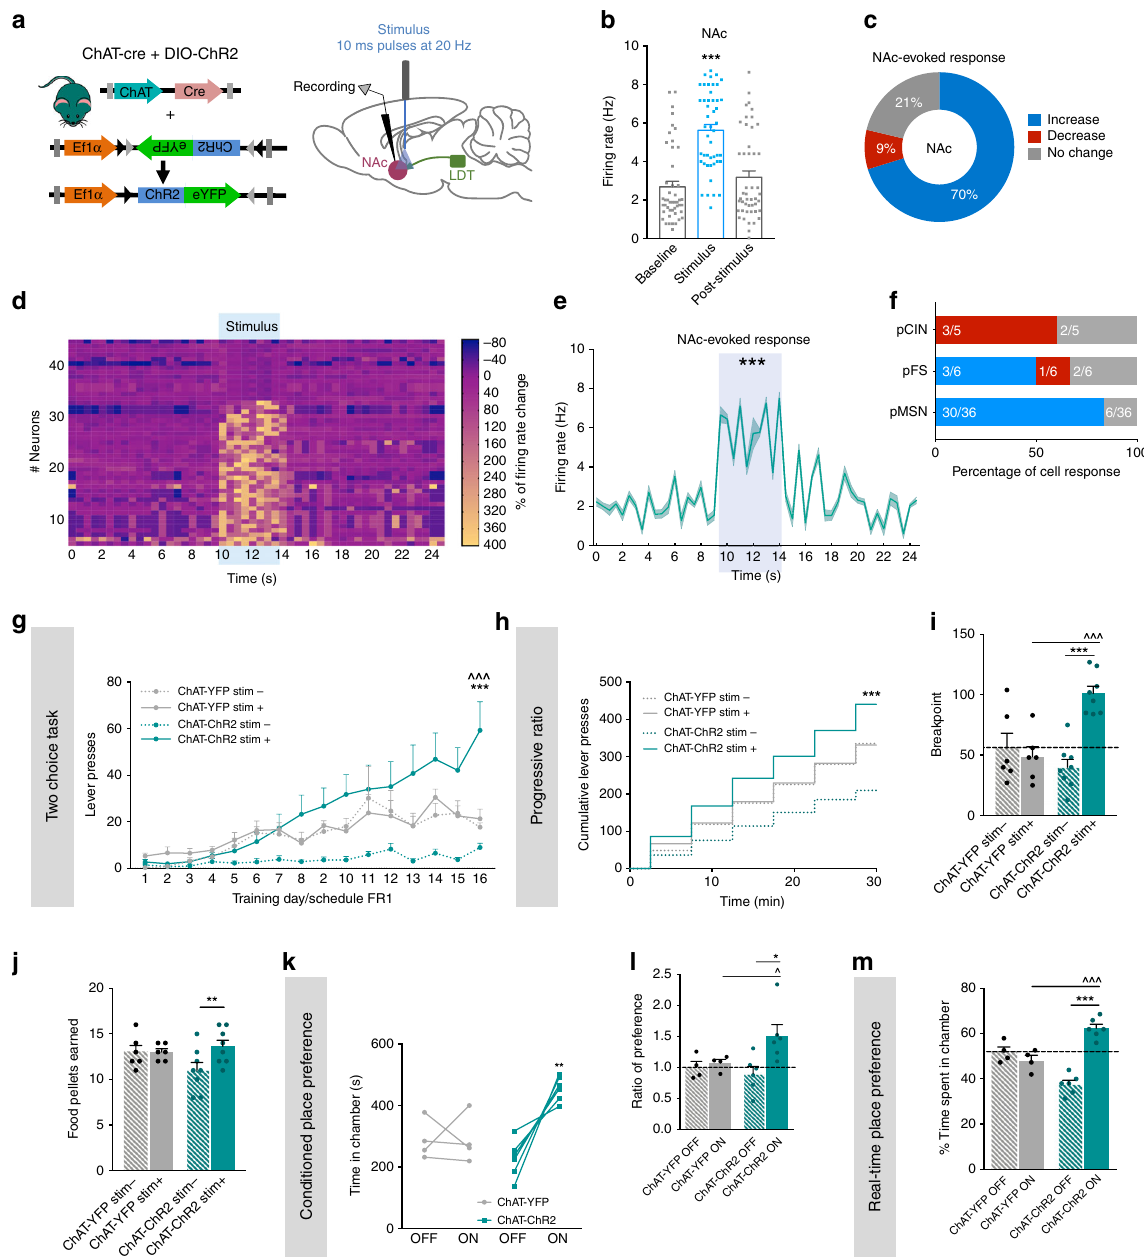
Fig. 4 Activation of LDT-NAc cholinergic terminals increases motivation and induces preference. a Strategy used for optogenetic manipulation of LDT cholinergic terminals in the NAc. DIO-ChR2 was injected in the LDT of ChAT-cre mice, and optical stimulation was performed in the terminals in the NAc. b LDT cholinergic terminals stimulation increase NAc net fi ring rate ( n = 5 animals; 47 cells; RM 1way ANOVA). c The majority of NAc cells show an increase in the fi ring rate during stimulation, 21% present no change and 9% decrease activity. d Heatmap representation of percentages of cell responses in the NAc when LDT cholinergic terminals are stimulated. e Average distribution fi ring rate of NAc neurons showing an increase in activity during stimulation period (KS test). f Percentage of responses of each NAc cell type to cholinergic LDT terminal activation. g Time-course representation of the responses in the two-choice task of ChAT-ChR2 ( n = 8) and ChAT-eYFP ( n = 6) mice. Activation of LDT-NAc cholinergic terminals enhances responses for stim + lever in ChAT-ChR2 animals, but not in control ChAT-YFP group. h Cumulative presses performed during the progressive ratio task show that ChAT-ChR2 animals press more on stim + lever. i Increased breakpoint for stim + lever in ChAT-ChR2 animals, indicative of enhanced motivation. j Number of pellets consumed during progressive ratio sessions. k – l In the CPP, ChAT-ChR2 ( n = 6, two animals lost cannula) animals prefer the ON chamber, i.e., the one associated with NAc- LDT cholinergic stimulation, whereas no preference is seen in control group ( n = 4, two animals lost cannula). m In the RTPP test, ChAT-ChR2 animals also prefer the ON chamber. Values are shown as mean±s.e.m. *refers to difference between ChAT-ChR2 stim + and stim- lever, RM 2way ANOVA; ^refers to difference between ChAT-ChR2 stim + and ChAT-YFP stim + lever, RM 2way ANOVA. * p < 0.05; ** p <0.01; *** p